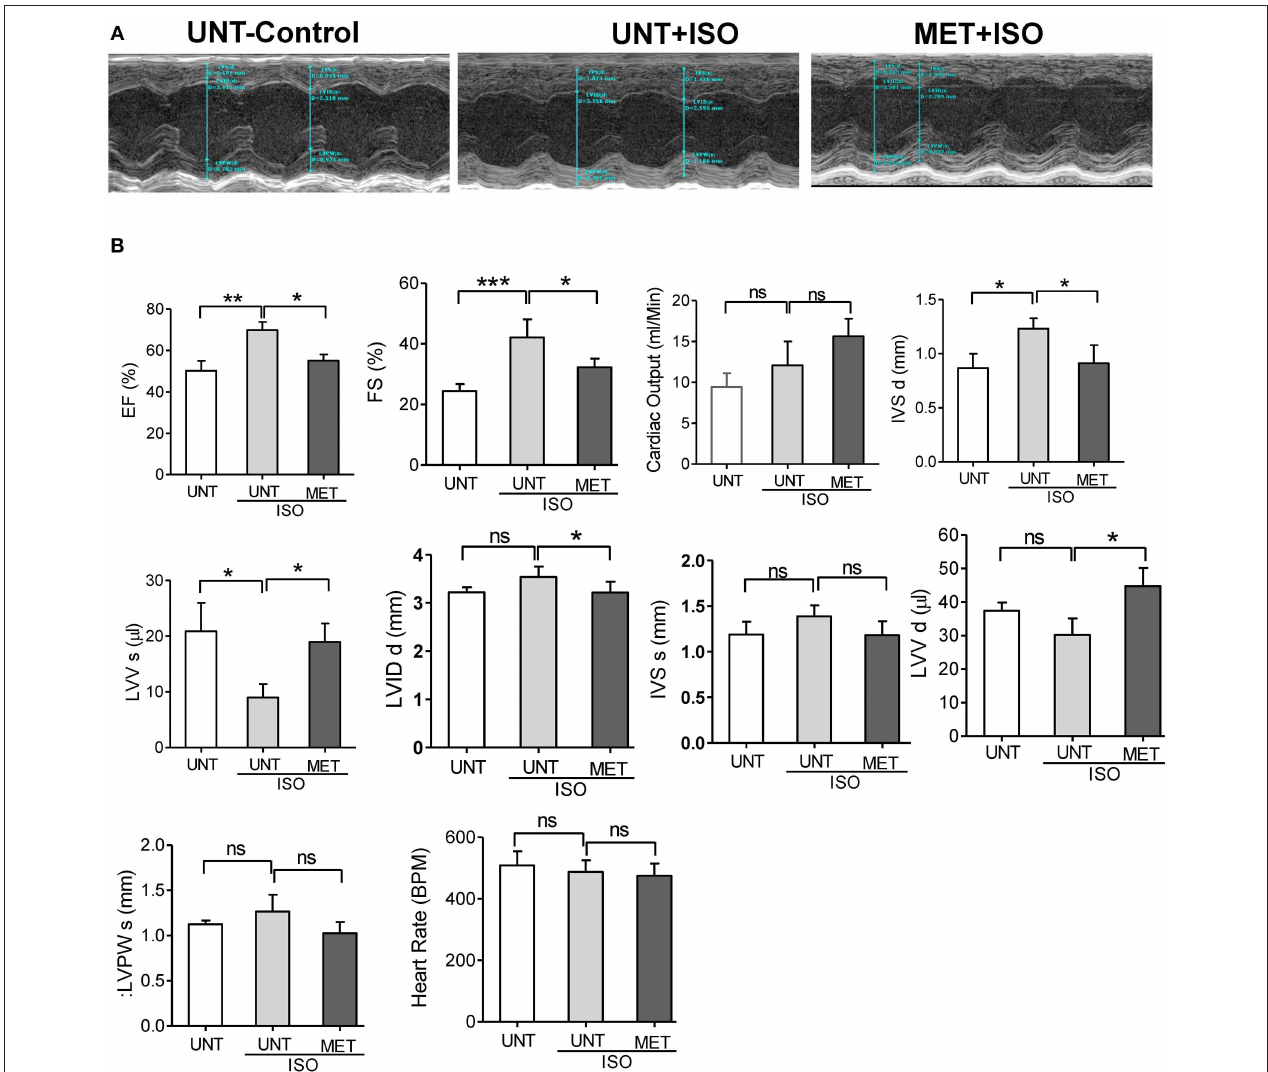
FIGURE 2 | Exercise preserved the heart function from Isoproterenol induced cardiac injury. Echocardiography was performed in all the three groups on the day of sacrifice using Vevo2100 high-resolution (38 MHz) imaging system. (A) Representative M-mode (SAX) images from untrained control, untrained + ISO and trained + ISO mice, (B) cardiac functions were analyzed using LAX B-mode and SAX M-mode images and represented as a bar graph. n = 5–6/group, values are represented as mean ± SD. Significance: * p < 0.05; ** p < 0.01; *** p < 0.001; ns, no